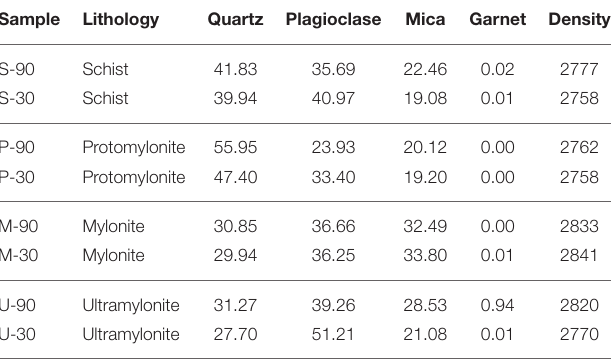
Frontiers in Earth Science |